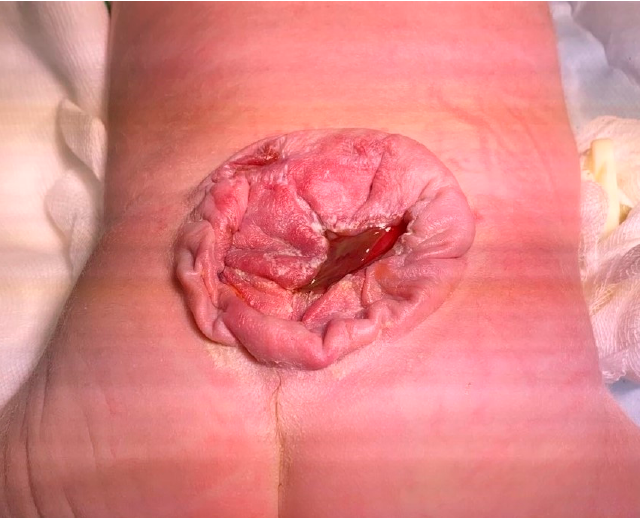
Figure 1. Intraoperative image of the large lumbosacral meningomyelocele.